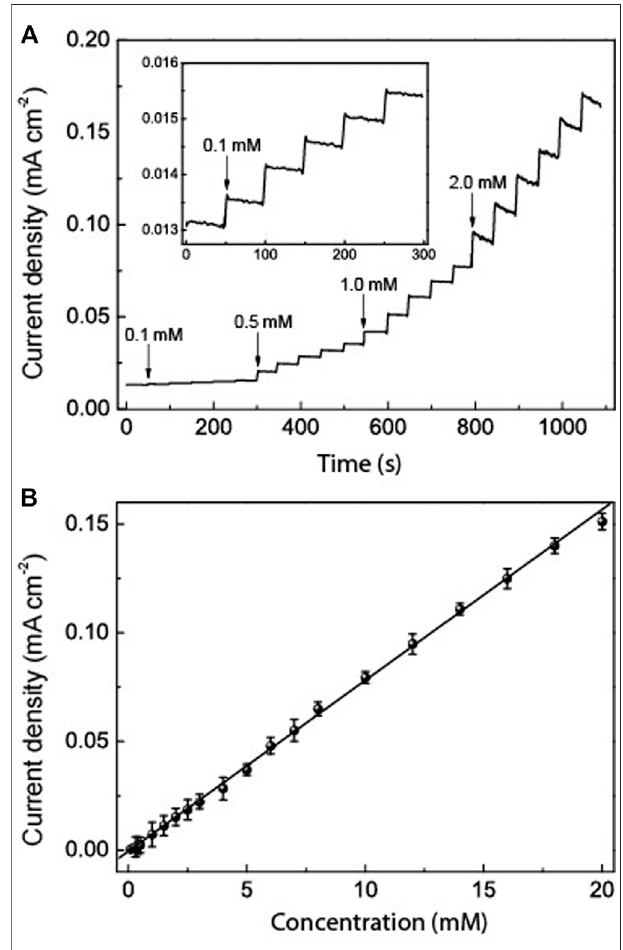
FIGURE 7 | (A) Typical amperometric response of HRP/Au NPs-PDA- PAA-graphene fi lm electrode after the sequential adding various concentrations of H 2 O 2 . The inset is the enlarged response with the lowest concentration of H 2 O 2 (B) The linear calibration curves of HRP/Au NPs- PDA-PAA-graphene fi lm electrode for H 2 O 2